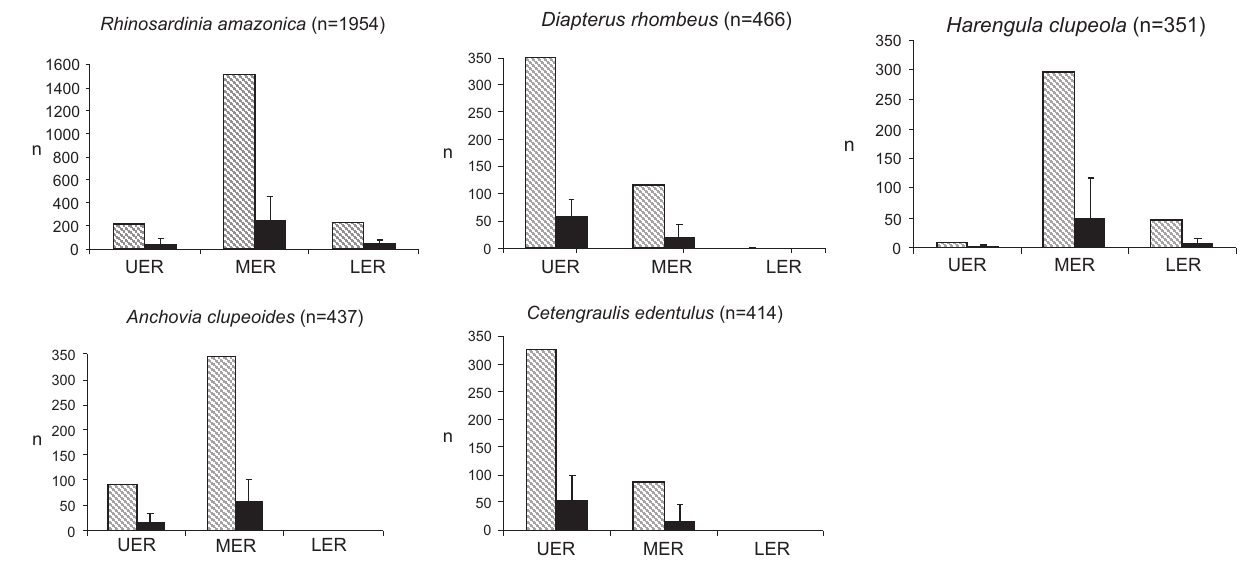
Figure 6. Similary analysis (R mode) based on the relative importance index.